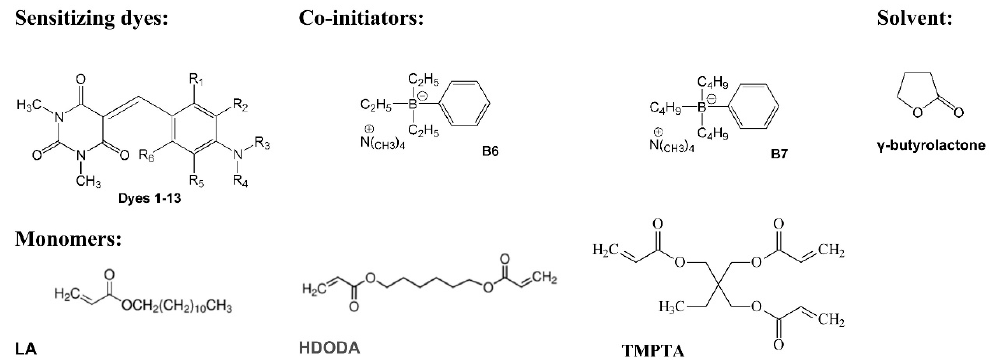
Figure 1. The general structure of dyes tested as light absorber and borate salt used as co-initiator in photoinitiated polymerization of acrylate monomers.